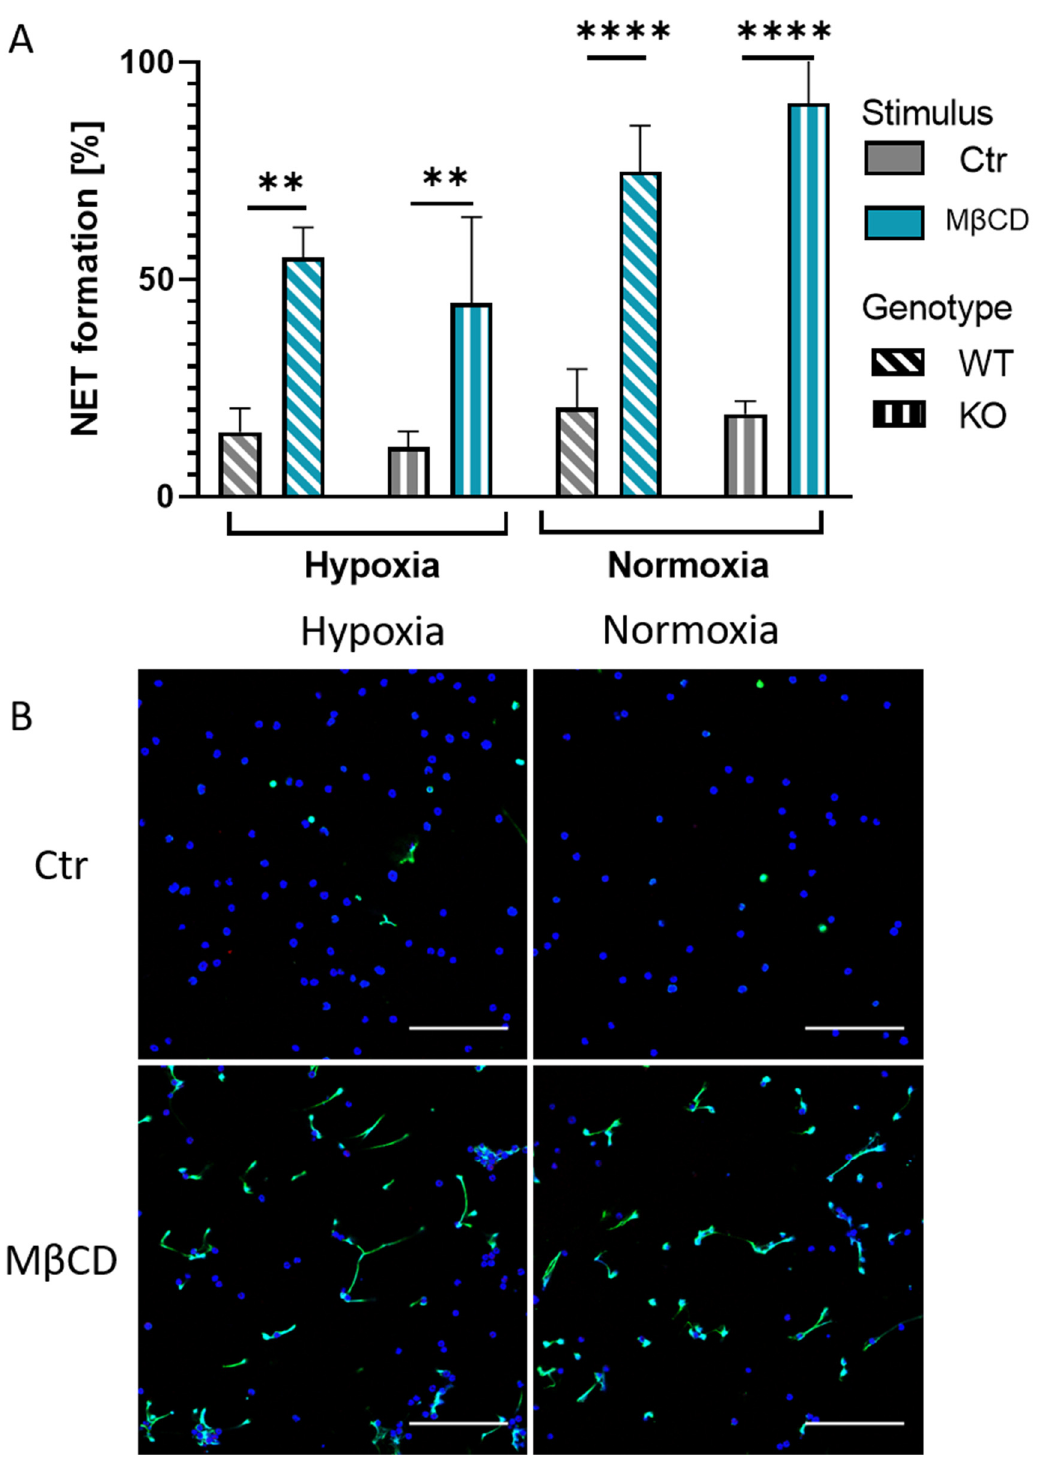
Figure 2. ( A ): Murine neutrophils of WT and KO mice were stimulated with cholesterol-depleting agent M β CD for 3 h under normoxia and hypoxia. Neither low oxygen conditions nor the genotype of the mice had a significant influence on the rate of NET formation. Significance was analyzed via the Kruskal–Wallis test with multiple comparisons. ( B ): Representative immune fluorescence images of KO mice. Left side, hypoxia incubated neutrophils after control or M β CD stimulation. Right side, normoxia incubated neutrophils after control or M β CD stimulation. Blue: DAPI, green: DNA/Histone1 complexes. Scale bars: 100 µm. N = 3. (** p < 0.01, **** p < 0.0001).